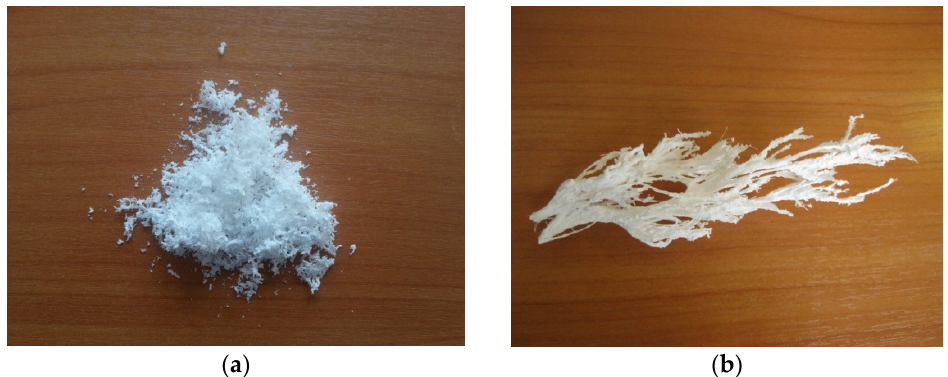
Figure 3. SAS formation of polycarbonate (PC) powder at 1 mL/min ( a ) and PC icicles at 2 mL/min ( b ).